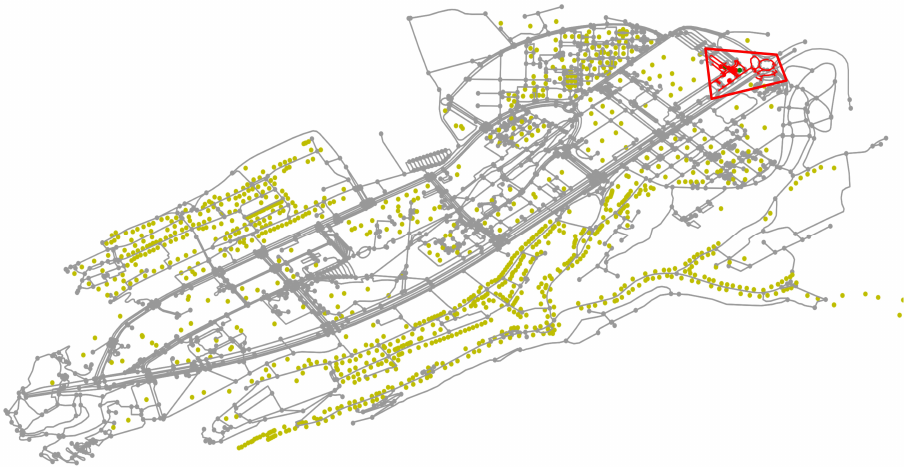
Figure 13. A solution that yields a low global walking distance, but also yields low user